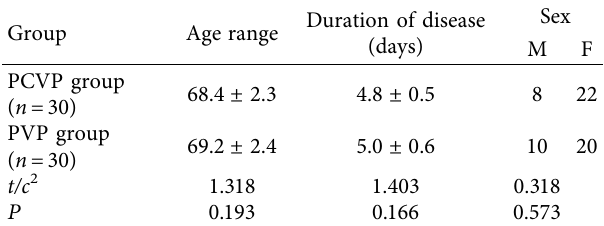
Table 1: General data of patients ( x ± s )/[cases (%)].